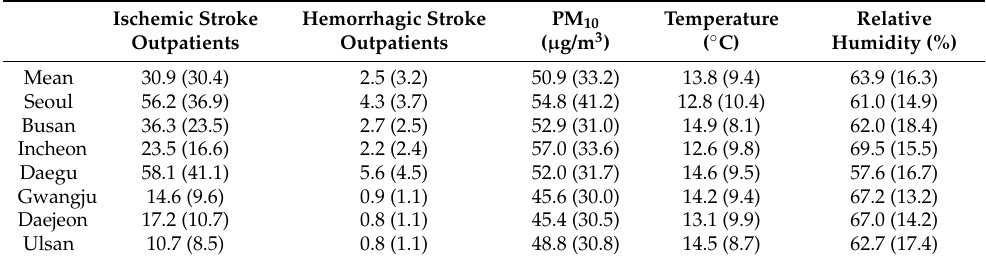
The daily average PM 10 concentration in the seven major cities from 2002–2015 was 50.9 µg/m 3 . The annual average concentration of PM 10 was 62.0 µg/m 3 in 2002 and de- creased to 45.5 µg/m 3 in 2015. The decreasing temporal trend of PM 10 concentration was was similar over the seven major cities (Figure 1). similar over the seven major cities (Figure 1).